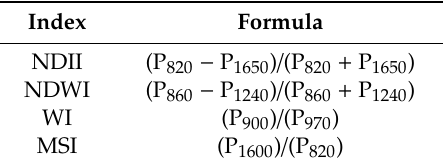
Table 1. Vegetation water status